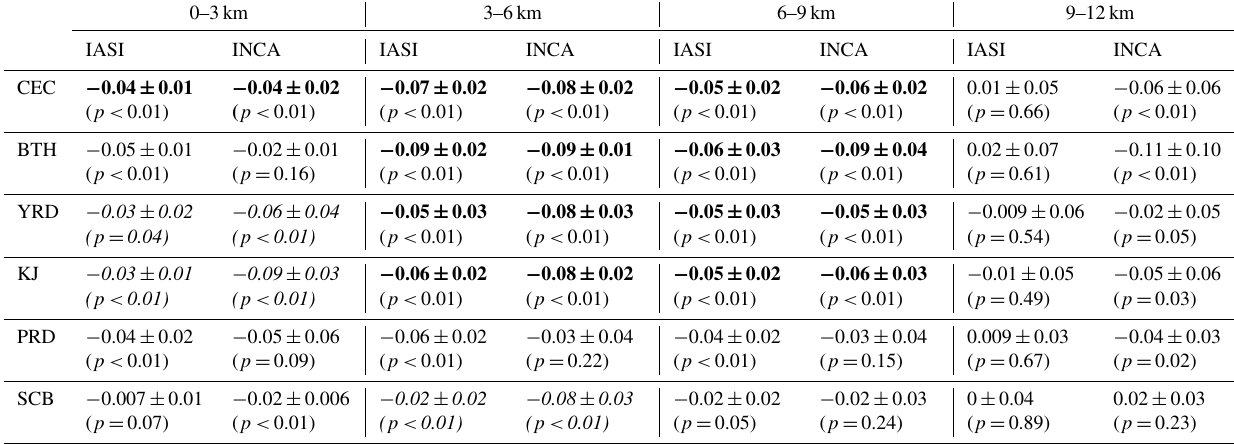
Table 3. Calculated trends in Dobson units per year from IASI observations and INCA simulations for the different regions of Fig. 1 and the 0–3, 3–6, 6–9, and 9–12km partial columns. The associated p value is indicated for each trend. The trend values are shown in bold font when both IASI and INCA trends have associated p < 0.05 and are within 40% agreement. The trend values are shown with italics when both IASI and INCA trends have associated p < 0.05 but with differences larger than 40%.